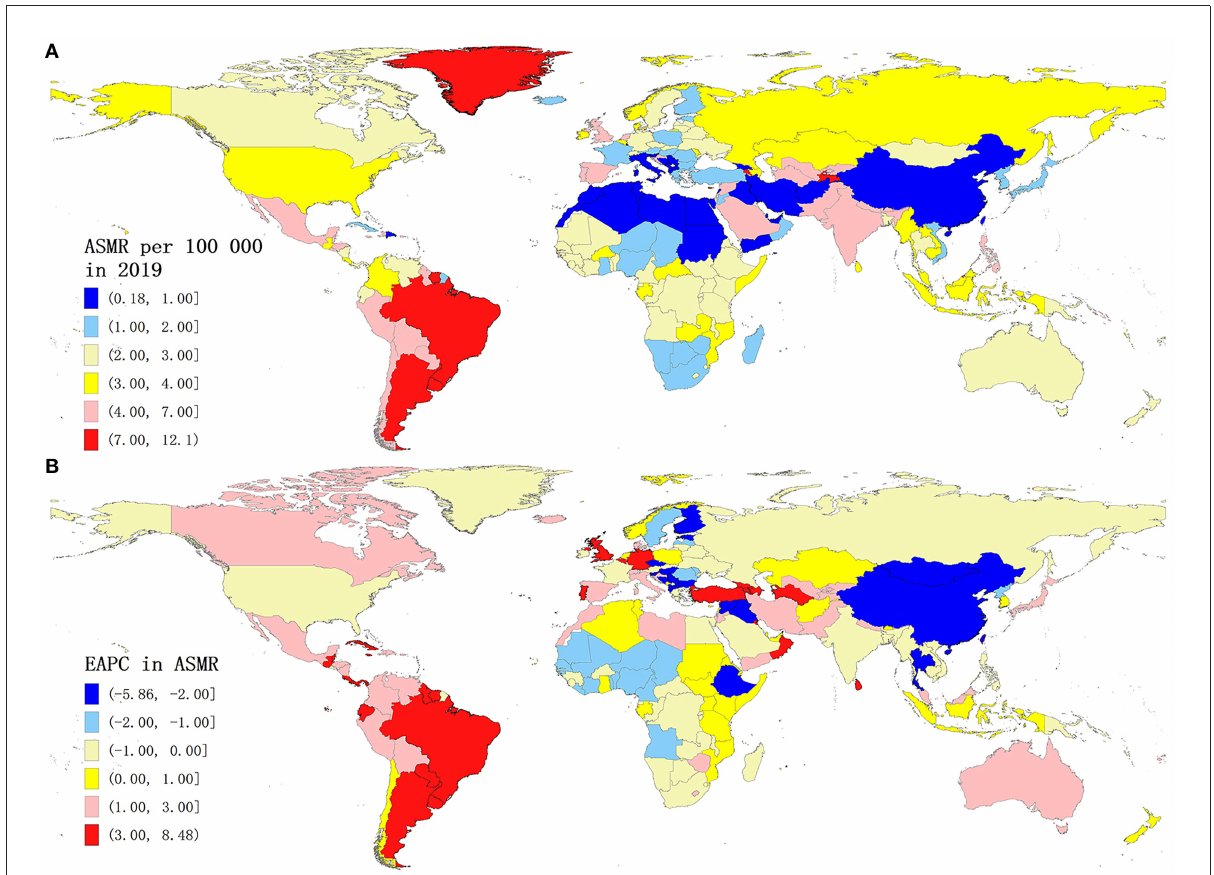
FIGURE2 Global mortality of urinary tract infection for both sexes across 204 countries and territories. (A) ASMR of urinary tract infection in 2019. (B) EAPC in the ASMR of urinary tract infection from 1990 to 2019. ASMR, age-standardized mortality rate; EAPC, estimated annual percentage